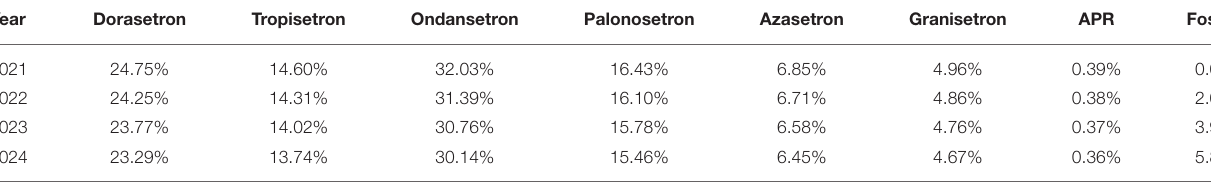
TABLE 6 | Market share changes of antiemetics within 3 years.